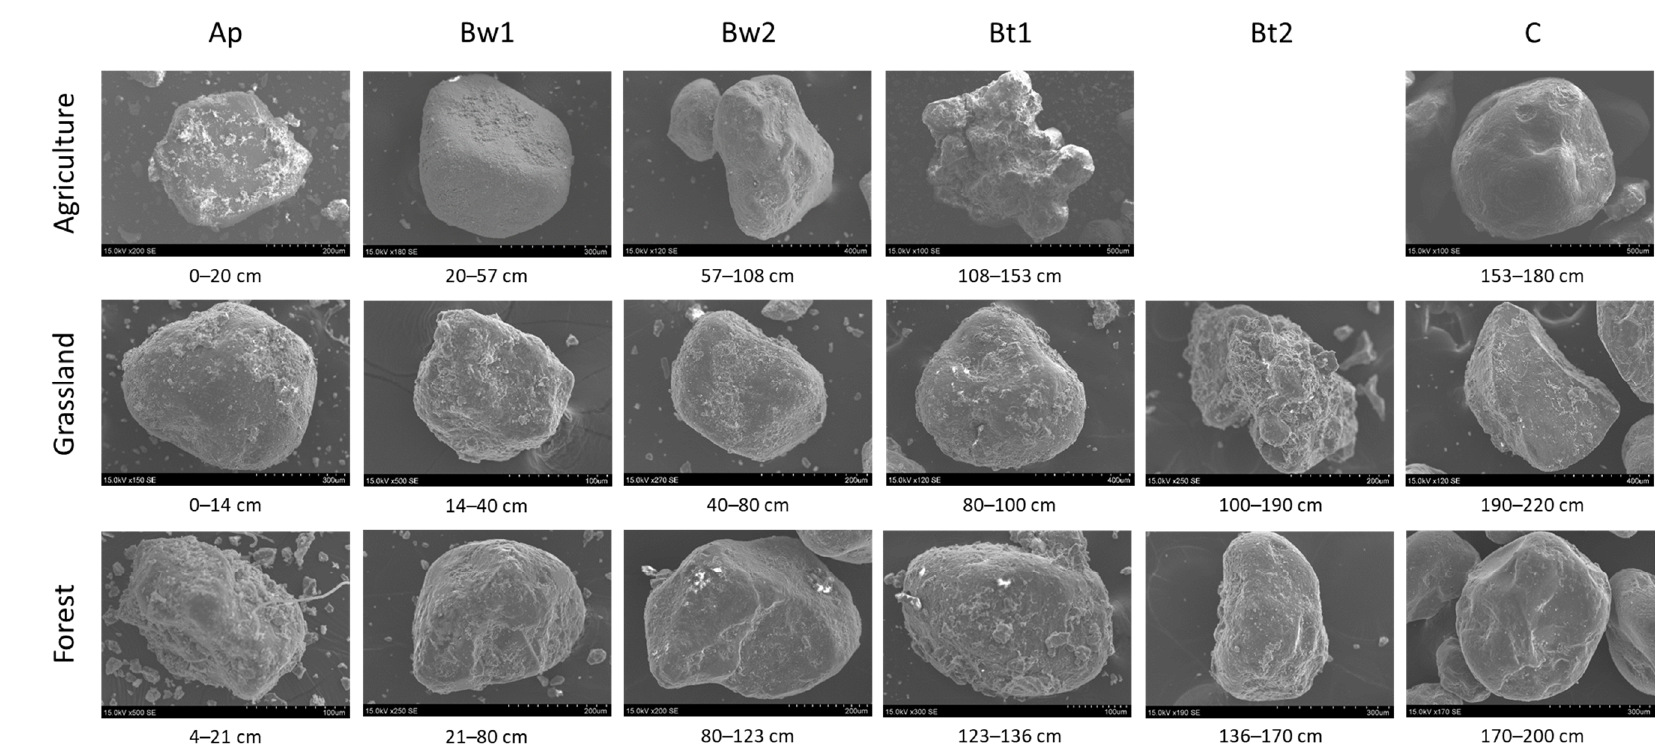
Figure 4. SEM images of particle-size grains of different soil horizons from three sandy Alfisols under different land use.